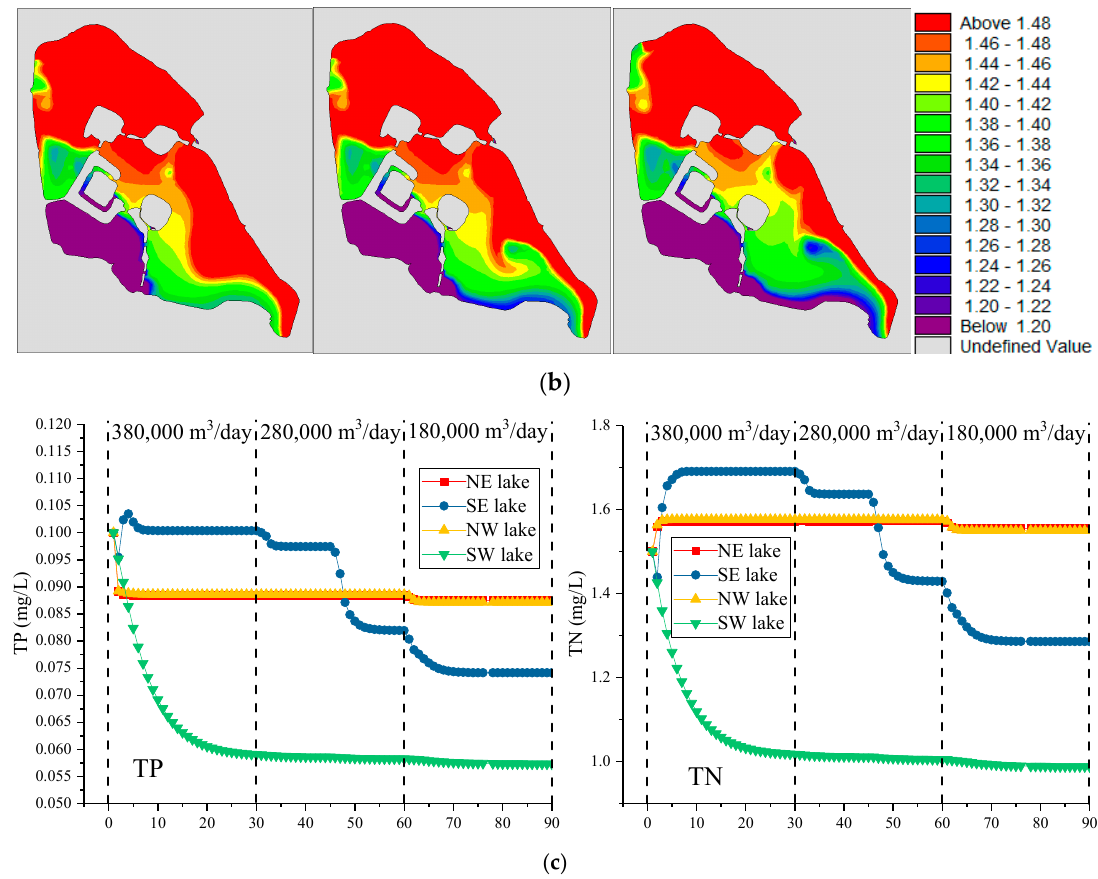
Figure 15. ( a , b ) are the concentration distribution of TP(total phosphorus) and TN(total nitrogen) under northwest wind condition. From left to right, water diversion schemes for 350,000 m 3 /day, 280,000 m 3 /day and 180,000 m 3 /day respectively; ( c ) shows the changes in water quality under different water diversion schemes for different lake districts in Xuanwu Lake.